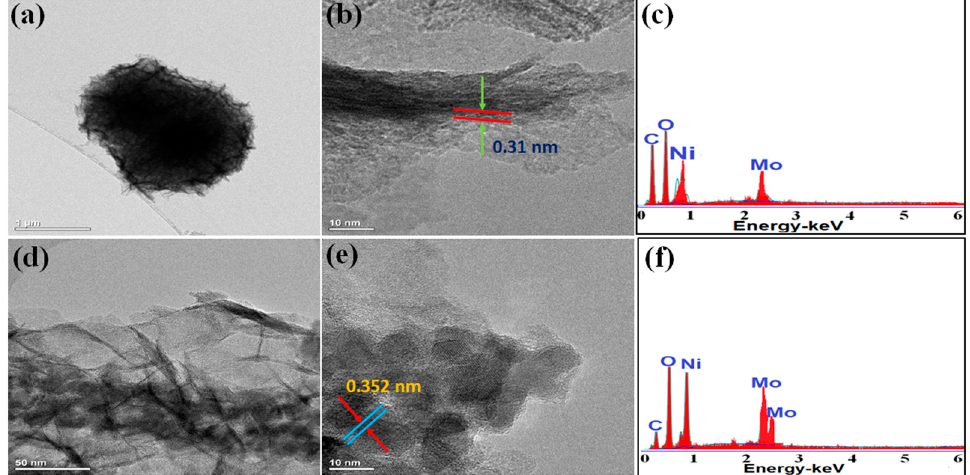
Figure 2. ( a , b ) HR-TEM and TEM images and ( c ) EDX pattern of NF/NiMoO 4 on nickel foam. ( d , e ) TEM images and ( f ) Energy-dispersive X-ray spectroscopy (EDX) pattern of NF/NiMoO 4 /NiMoO 4 nanostructure on nickel foam.